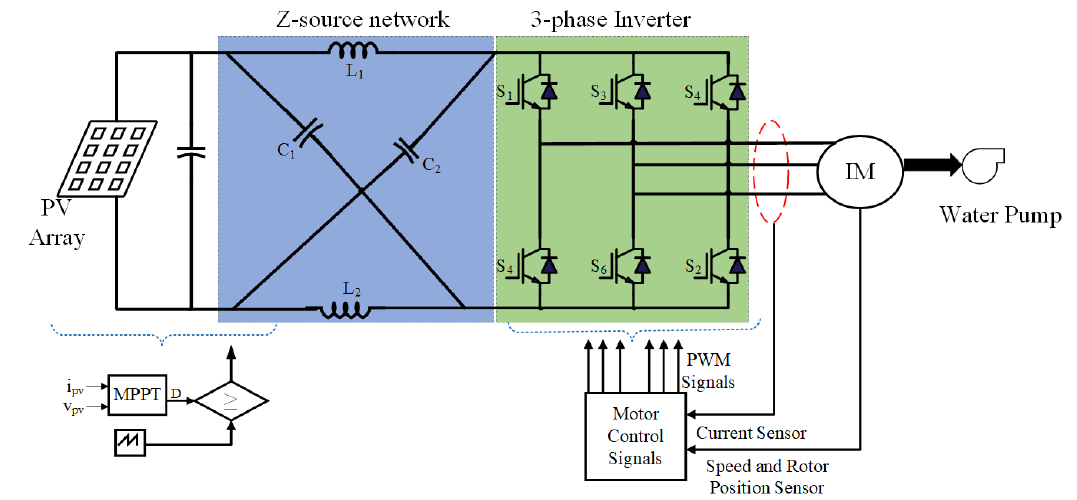
Figure 1. Circuit diagram of the photovoltaic (PV)-fed Impedance (Z)-source inverter (ZSI)-fed motor drive for pumping application.